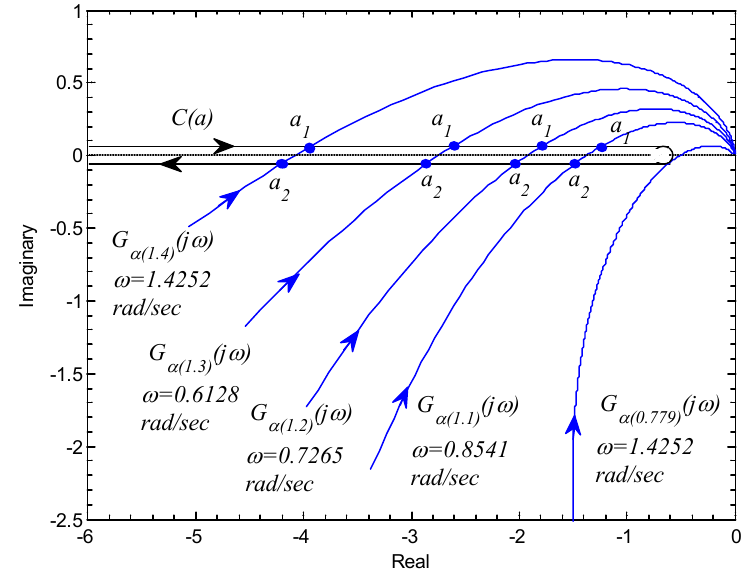
for Equation (47) where is a relay 𝛼